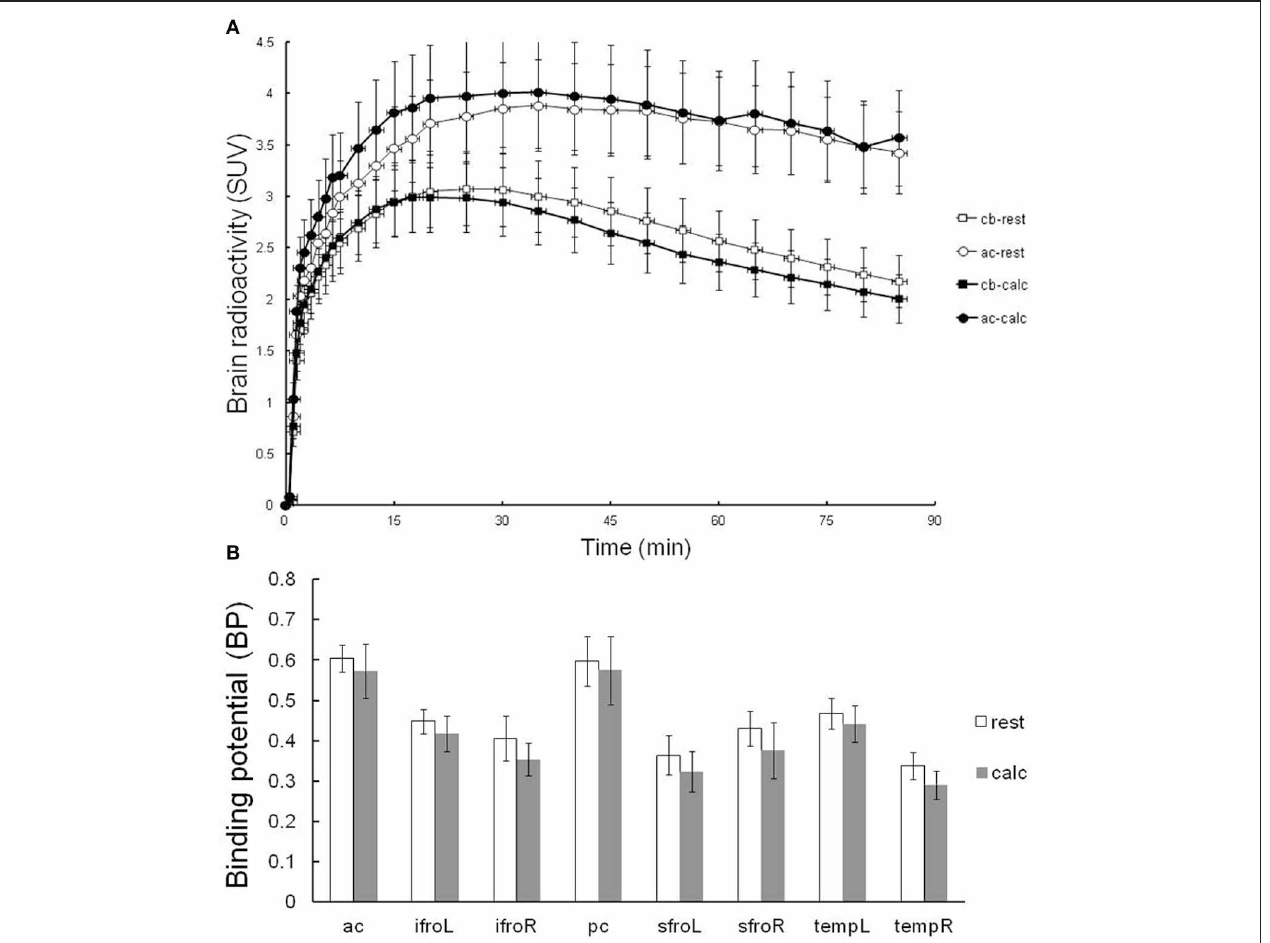
and attentive conditions. Abbreviations: ac, anterior cingulate gyrus; ifroL, left inferior prefrontal cortex; ifroR, right inferior prefrontal cortex; pc,